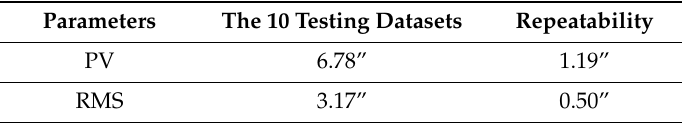
( b ) Figure 10. ( a ) Probability plot for normal distribution before compensation. ( b ) Probability plot for normal distribution after compensation.